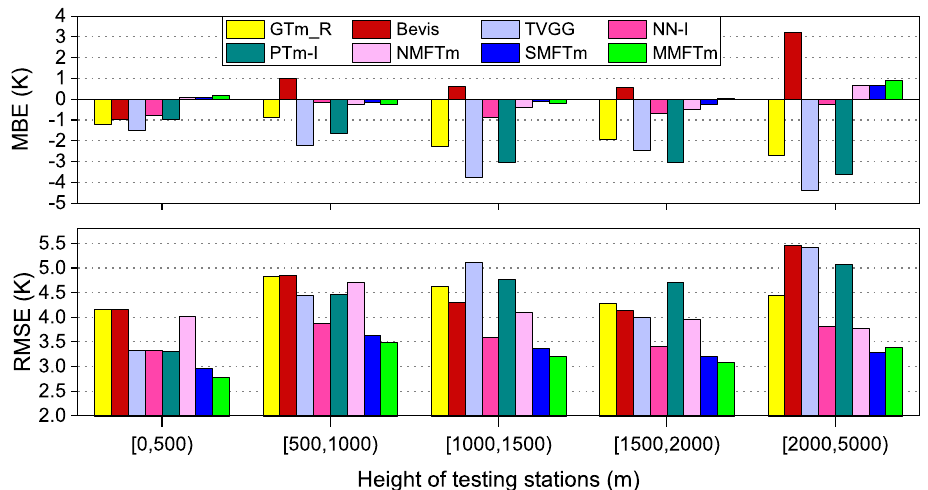
Figure 15. Results of MBE and RMSE for different models at different height